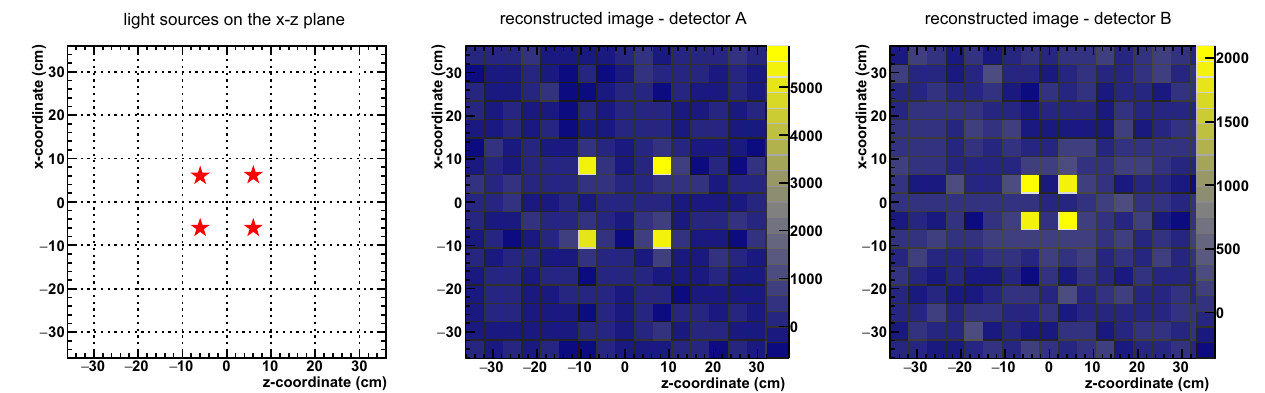
Fig. 7 Simulation of the four light-points. The left frame represents the actual sources in the x − z view. The other two frames represent the reconstructed signal by means of two different detectors.